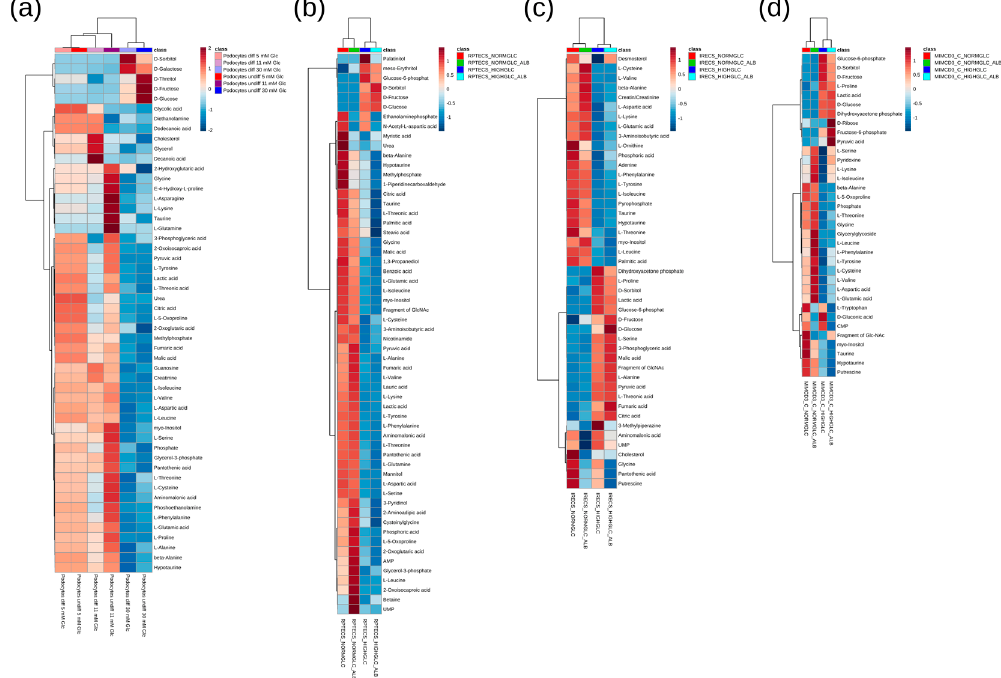
Figure 2. Heat map and cluster analysis (Pearson/Ward) of the significantly altered (FDR corrected q < 0.05) metabolites for the podocyte cell lines ( a ), for the proximal tubular cell lines RPTECs ( b ), and iRECs ( c ), as well as for the collecting duct cell line mIMCD-3 ( d ). Range scaling was performed to obtain the z-scores. “Fragment of Glc-NAc” is an indistinguishable fragment of either N-acetylglucosamine-1-phosphate or N-acetylglucosamine-uridine diphosphate, with the first being the direct precursor of the latter in the hexose amine pathway. The individual results and pairs of significance obtained by Tukey’s HSD are displayed in Supplementary Table 2. In each cellular system (i.e., differentiated podocytes, undifferentiated podocytes, RPTECs, iRECs, and mIMCD-3 cells), the intensities were normalized to the corresponding physiological condition so as to focus on the treatment specific effects. n = 4–8.